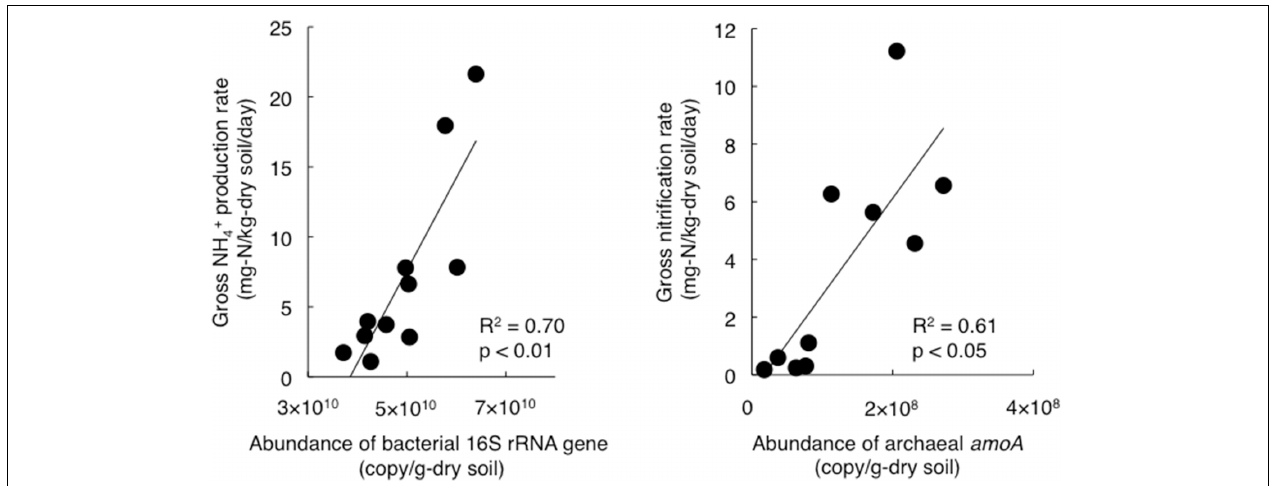
FIGURE 2 | Relationships between the gross NH + 4 production rate and the bacterial 16S rRNA gene abundance (Left panel, y = 7 × 10 − 10 x - 25.5, R 2 = 0 . 70, p < 0 . 05), and between the gross nitrification rate and the archaeal amoA abundance (Right panel, y = 3 × 10 − 8 x - 0.5, R 2 = 0 . 61, p < 0 .